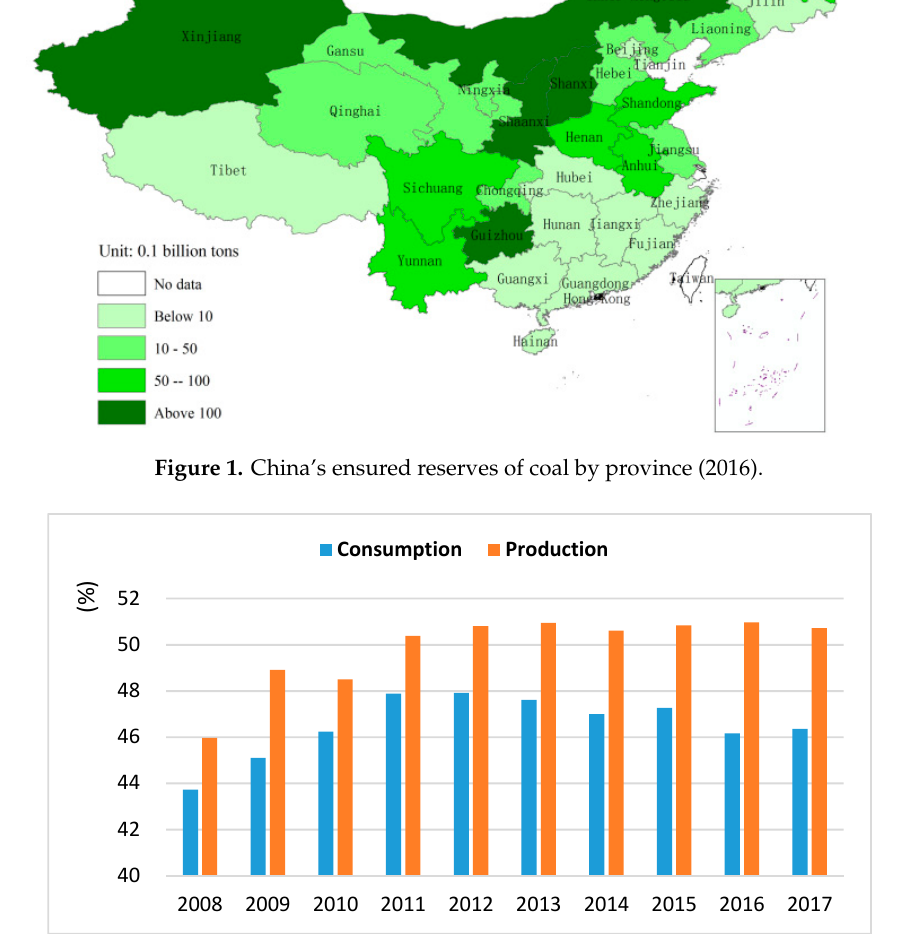
Figure 2. China's share of coal production and consumption in the world.